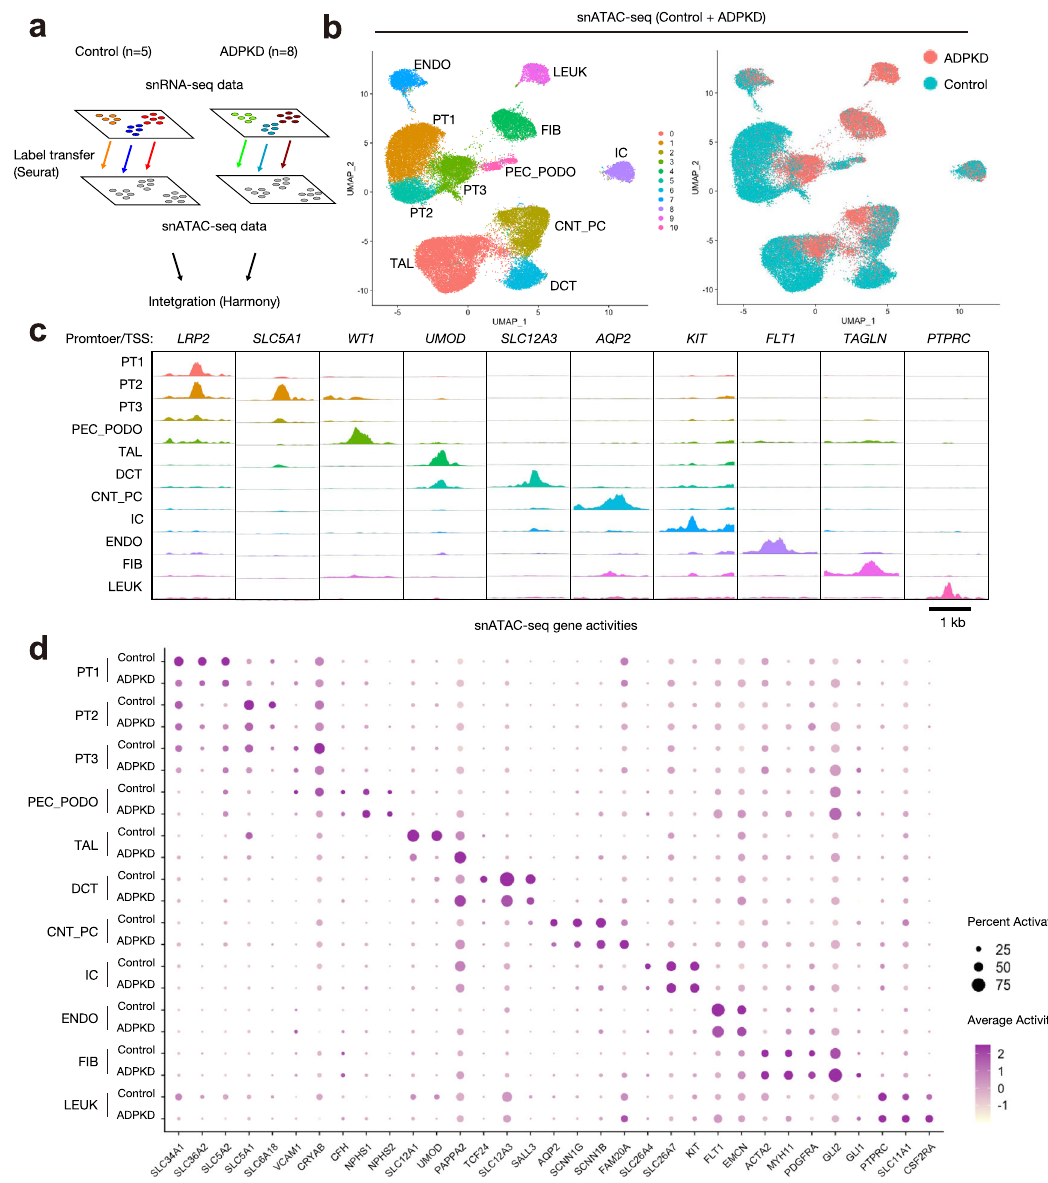
Fig. 2 | Single-nucleus chromatin accessibility pro fi ling on human ADPKD kidneys. a Graphical abstract of multimodal integration strategy for the snATAC-seq datasets. The integrated ADPKD or control snATAC-seq datasets were label-transferred from cognate snRNA-seq datasets, and the snATAC-seq datasets were fi ltered using an 80% prediction score threshold for cell-type assignment.After fi ltering,controlandADPKDdatasetsweremerged,andbatch effect was corrected with Harmony. See Supplementary Fig. 7 and Method section for detail. b UMAP plot of snATAC-seq dataset with gene activity-based